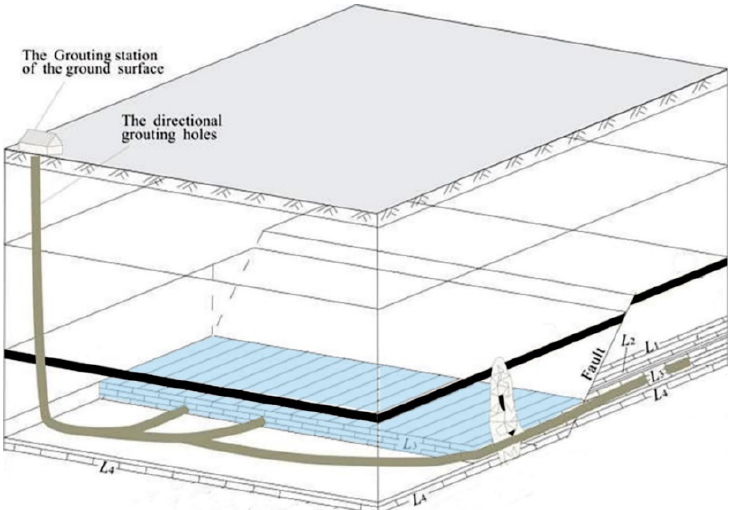
Figure 1. Three-dimensional model diagram of high-pressure grouting technology with directional drilling on the ground.